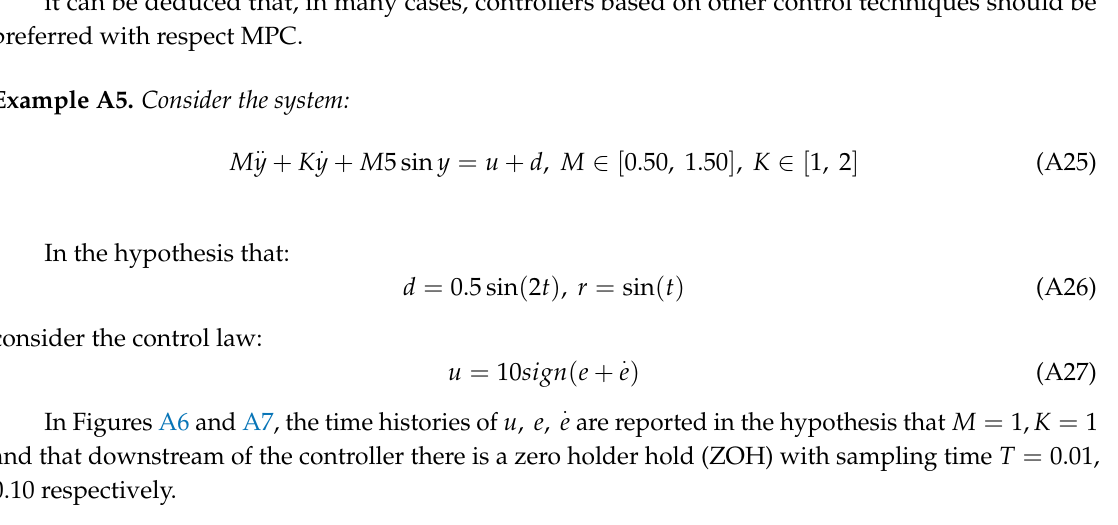
Figure A5. Time histories of u , r , y with an MPC controller in the hypothesis of measurement noise on y .